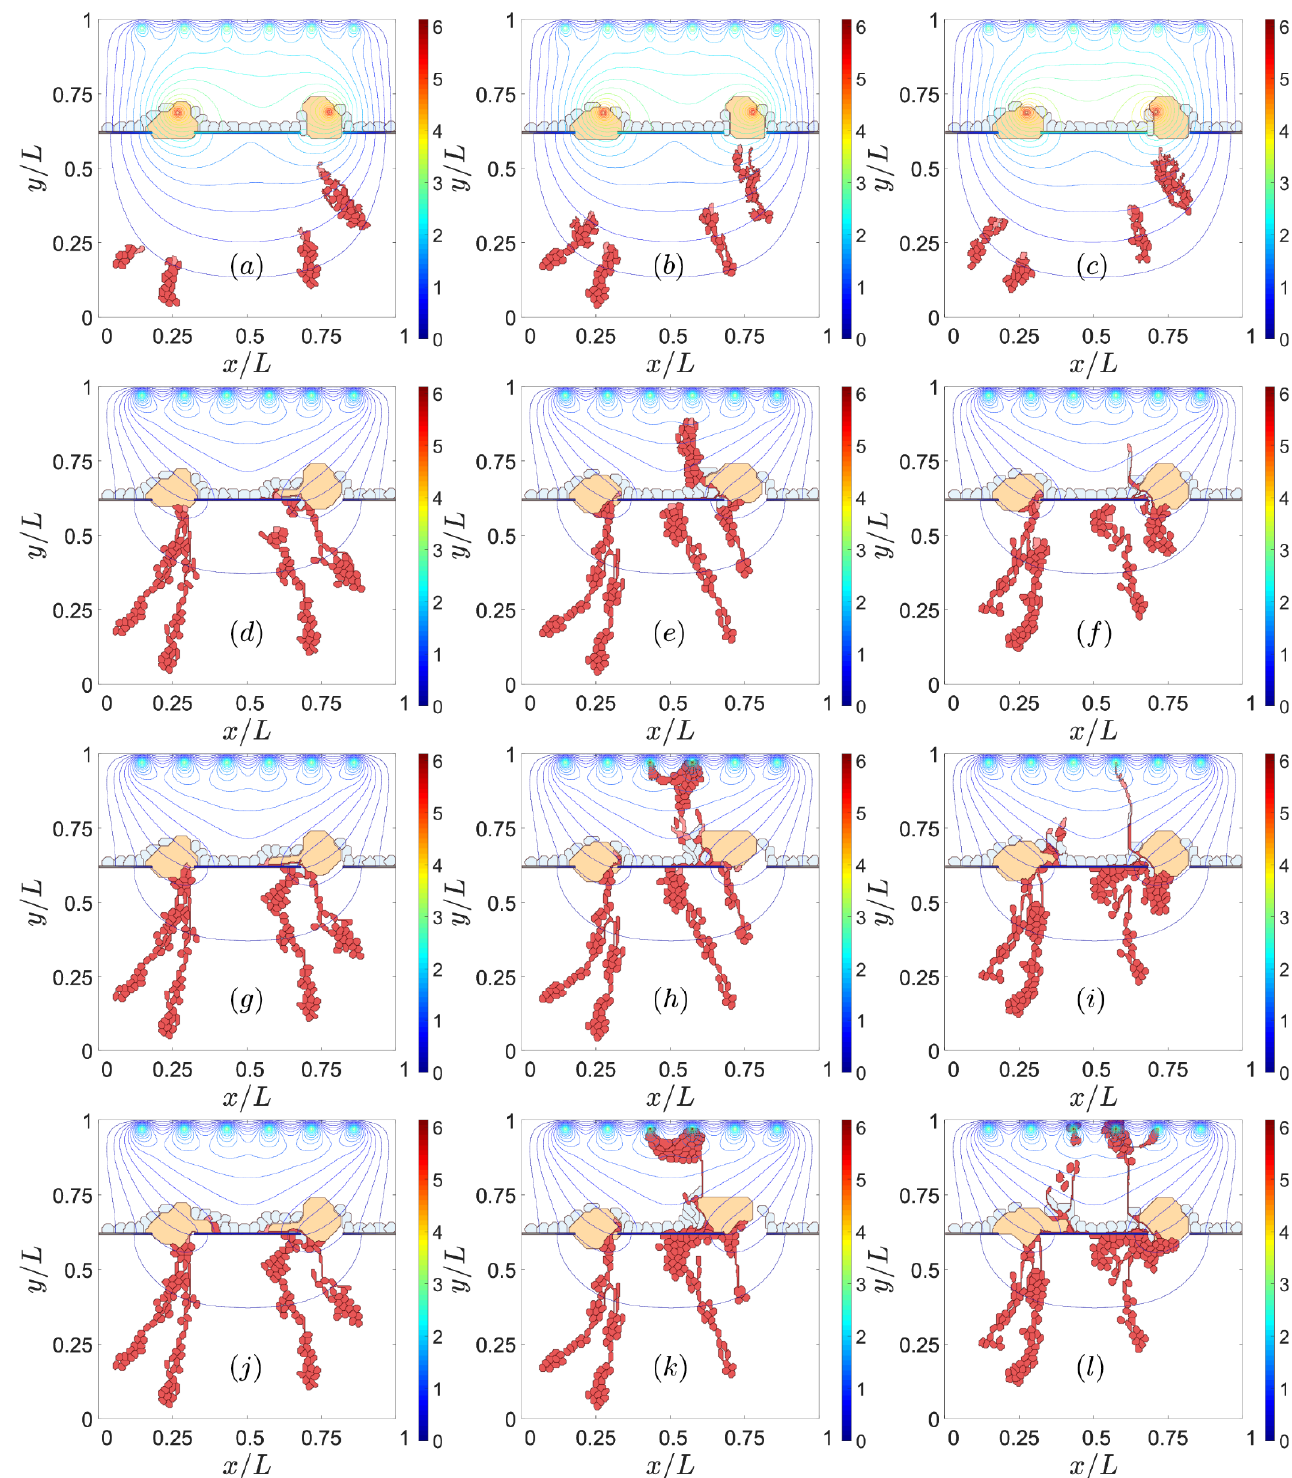
Figure 8. Effect of Jagged and Delta production on CNV. Type 1 CNV for r J = 500 molec/h, r D = 1000 molec/h, snapshots at times: ( a ) 601 MCTS, ( d ) 1801 MCTS, ( g ) 3601 MCTS, ( j ) 8001 MCTS. Type 2 CNV (reference simulation) for r J = 2000 molec/h, r D = 1000 molec/h, snapshots at times: ( b ) 601 MCTS, ( e ) 1801 MCTS, ( h ) 3601 MCTS, ( k ) 8001 MCTS. Type 2 CNV for r J = 2000 molec/h, r D = 7500 molec/h, snapshots at times: ( c ) 601 MCTS, ( f ) 1801 MCTS, ( i ) 3601 MCTS, ( l ) 8001